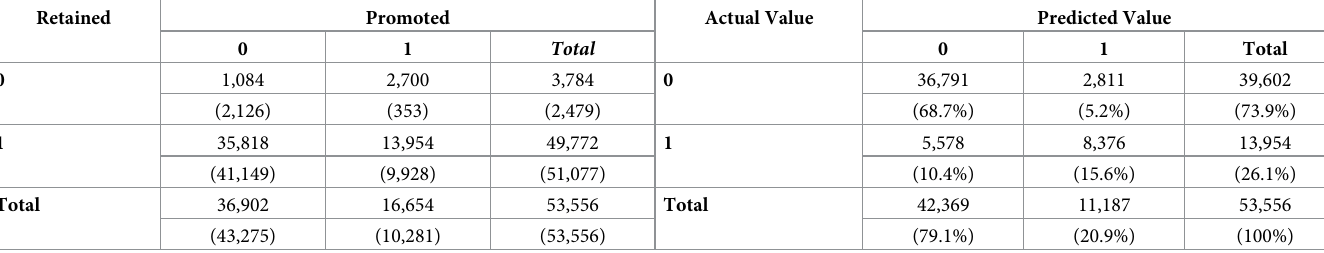
Actual vs. Fitted values (Fitted in parentheses) (1 = Promoted and